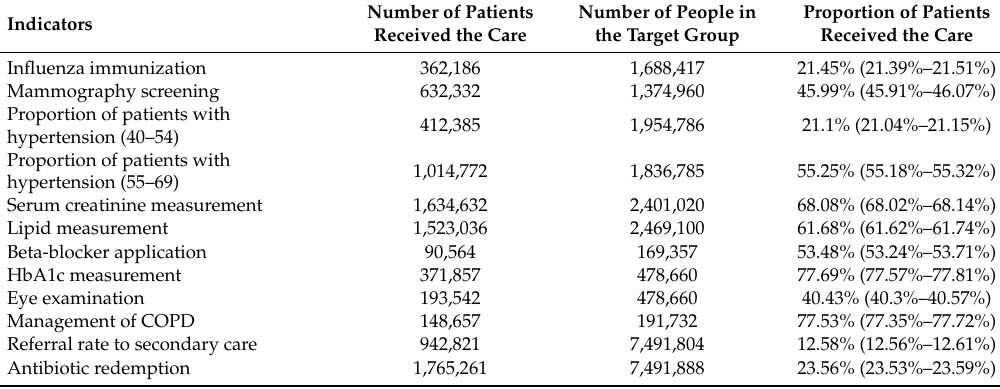
Table 3. The proportion of patients (with 95% confidence intervals) who received care in 2015 for the whole country by